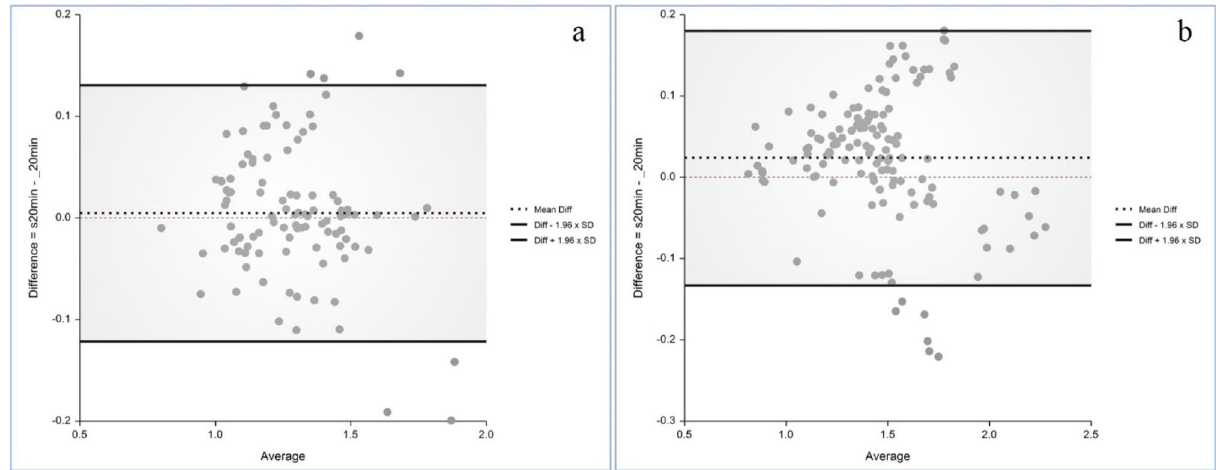
Figure 4. The Bland–Altman analysis for every regional SUVR shows a small mean difference between the PET 20m and sPET 20m images ( a , negative group; b , positive